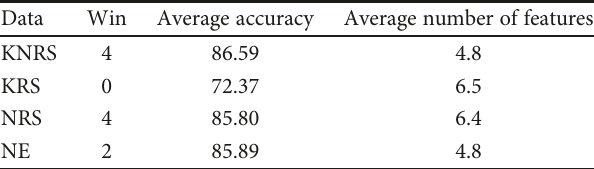
Table 8: Comprehensive correlations of the